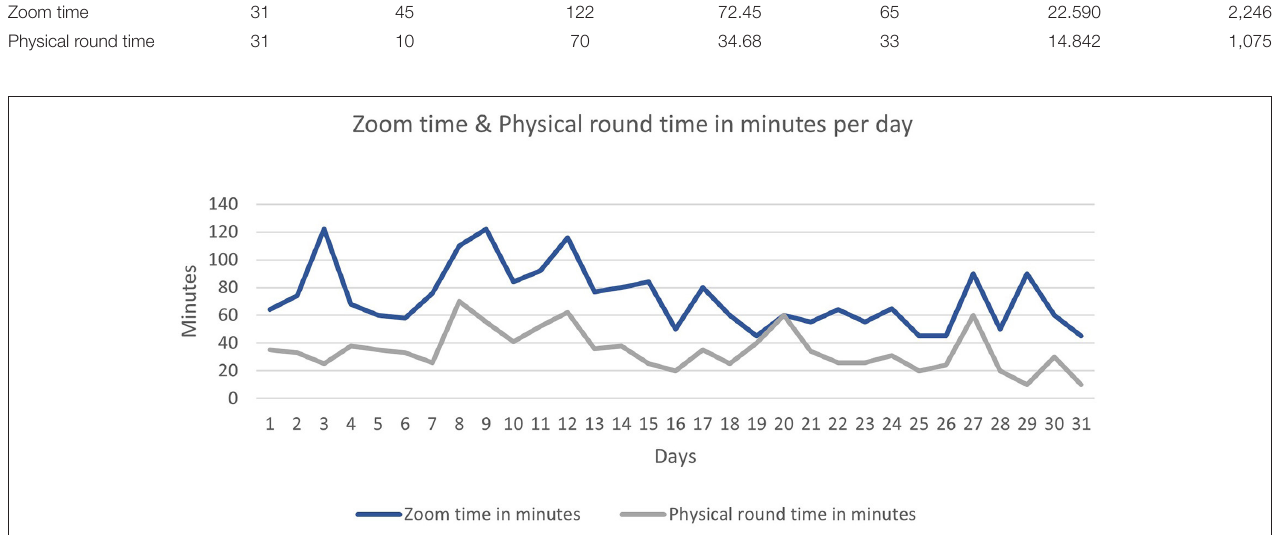
TABLE 1 | PICU Zoom round and physical round times (in minutes). N Minimum Maximum Mean Median